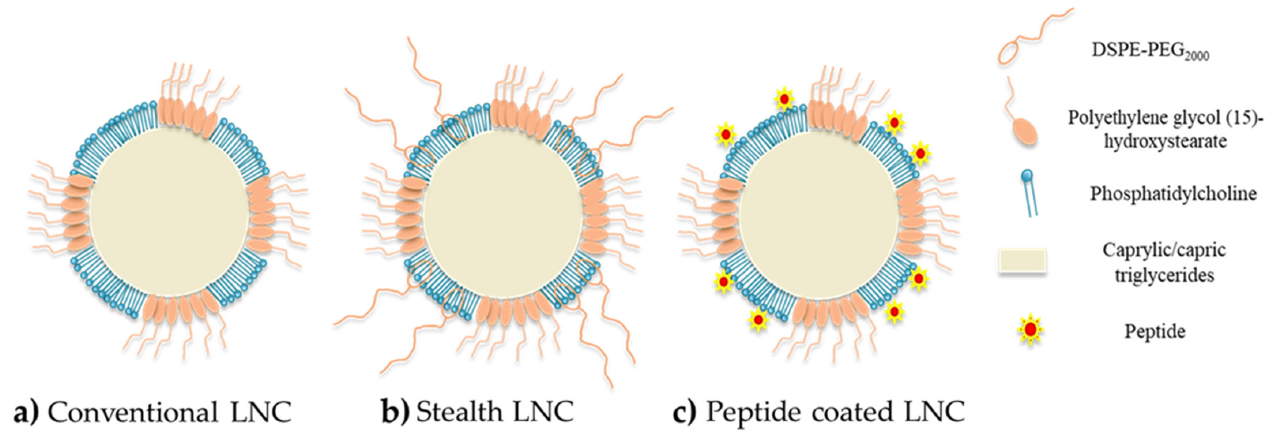
Figure 5. Schematic structure of LNCs: ( a ) conventional LNCs (without surface modification); ( b ) stealth LNCs with surface modification by DSPE-PEG 2000 ; ( c ) active targeting LNCs with surface modification by peptides.